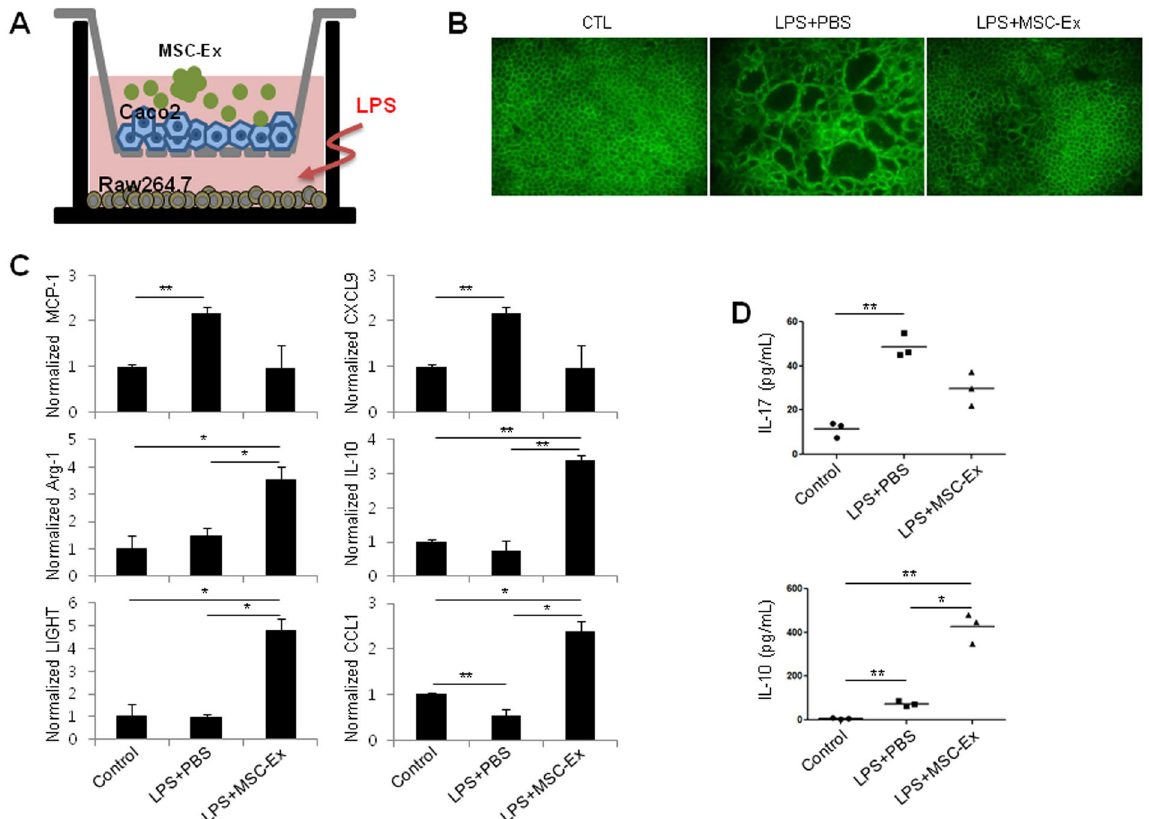
Figure 6. MSC-Ex protects intestinal adherens junctions in an in vitro model. (A) Schematic representation of the in vitro co-culture system. Caco-2 cells were cultured on the upper transwell inserts in multiple well plates containing RAW 264.7 cells. To imitate inflammation in the gut, LPS was added to the basolateral compartment, and MSC-Ex was administered to the apical side. (B) Immunofluorescent staining for E-cadherin using FITC- conjugated antibodies. Continued epithelial barrier, indicated by E-cadherin staining, is disrupted in the absence of MSC-Ex. Magnification, 40x. (C) The transcripts of MCP-1 (M1 marker), CXCL9 (M1 marker), Arg-1(M2 marker), IL-10 (M2 marker), LIGHT (M2 marker), and CCL1 (M2 marker) in RAW 264.7 cells were examined by qRT-PCR analysis after 4 h of LPS (1 μ g/mL) treatment and subsequent MSC-Ex (30 μ g/ mL) administration for 24 h. (D) The protein levels of IL-17 (top) and IL-10 (bottom) were measured by ELISA using culture supernatants from the basolateral side. Data are represented as the means ± s.d. ( n > 3 ). * P < 0.05, ** P < 0.005, *** P < 0.001